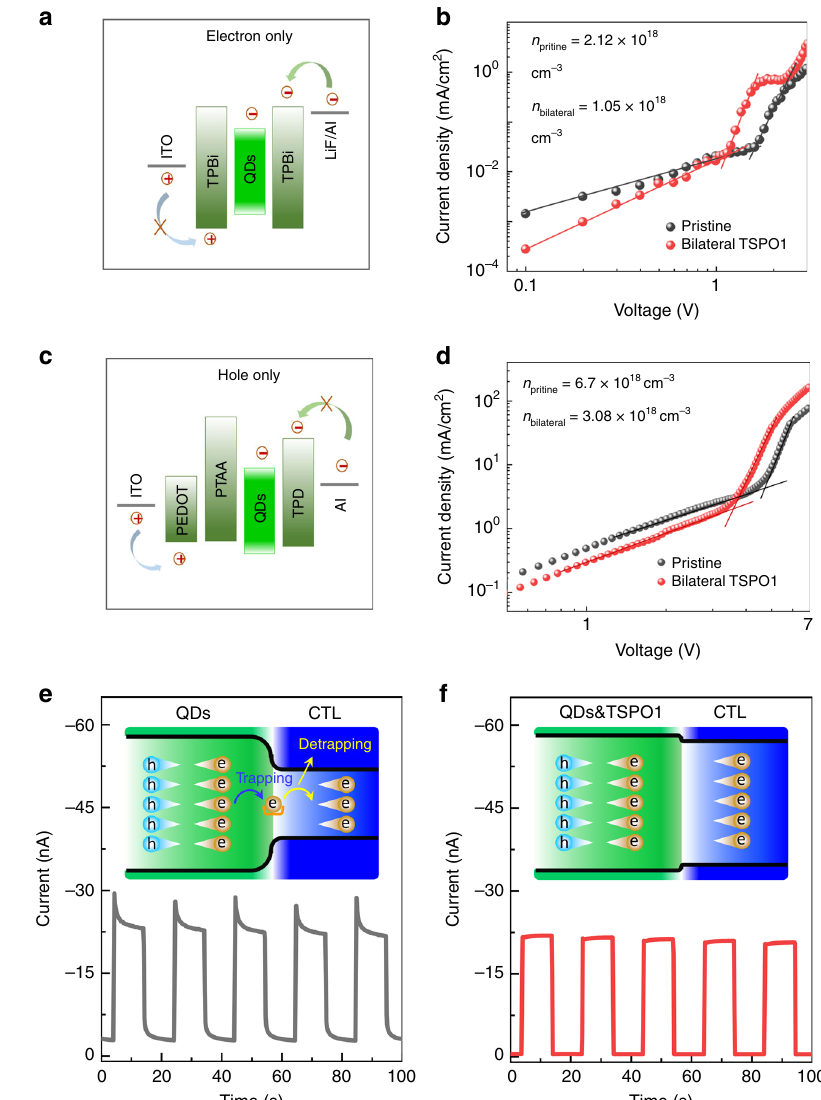
Fig. 7 Effects of passivation on defect states. a The structure diagram and corresponding ( b ) current density-voltage curve of electron-only devices based on pristine and passivated QD fi lms. c The structure diagram and corresponding ( d ) current density-voltage curve of hole-only devices based on pristine and passivated QD fi lms. Comparison of transient photocurrent of pristine ( e ) and passivated ( f ) QD fi lms. Insets are illustration of carrier-transporting process of pristine and passivated QD fi lms. Before passivation, the defects located on the surface of the QD fi lms or/and between the QD fi lms and carrier-transporting layers, which traps and detraps the carriers, and makes the unsteady current dynamic, especially in the case of light excitation. After passivation, the defects were greatly reduced, and the current is more stable. Source data are provided as a Source Data fi